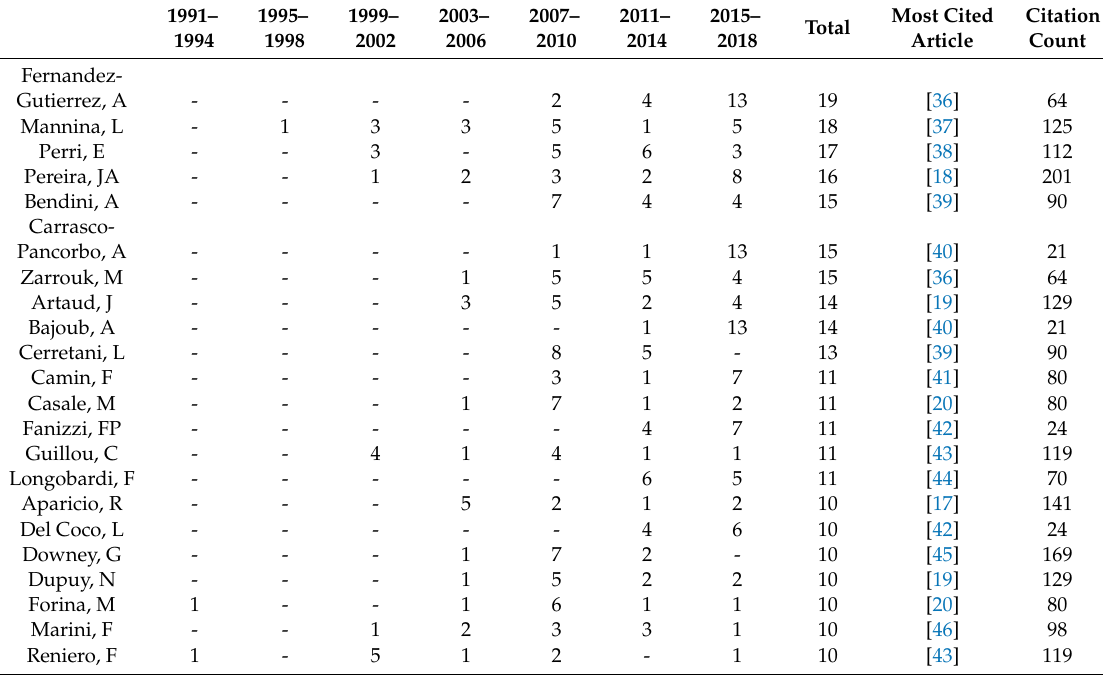
Table 3. Number of publications over time for the main authors (having a total of at least 10 articles) and most cited article for each author with its citation count up to